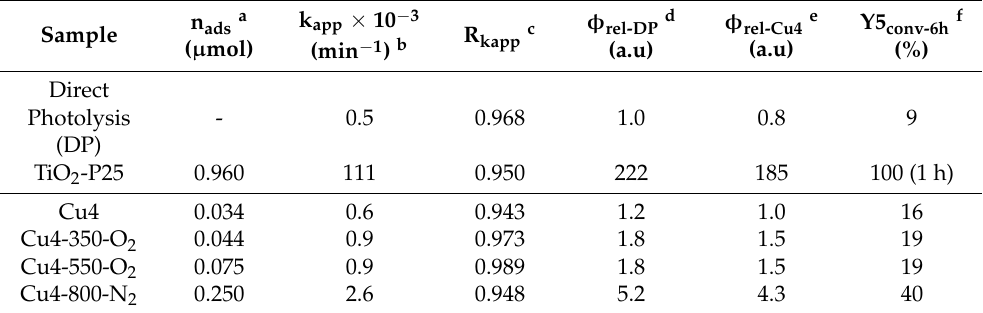
Figure 7. ( a ) Kinetics of dye Y5 photodegradation under artificial solar degradation on the series of Cu-based catalysts. ( b ) Linear regression of the kinetic data. Table 5. Summary of kinetic results of Y5 photodegradation on Cu-based photocatalysts under solar